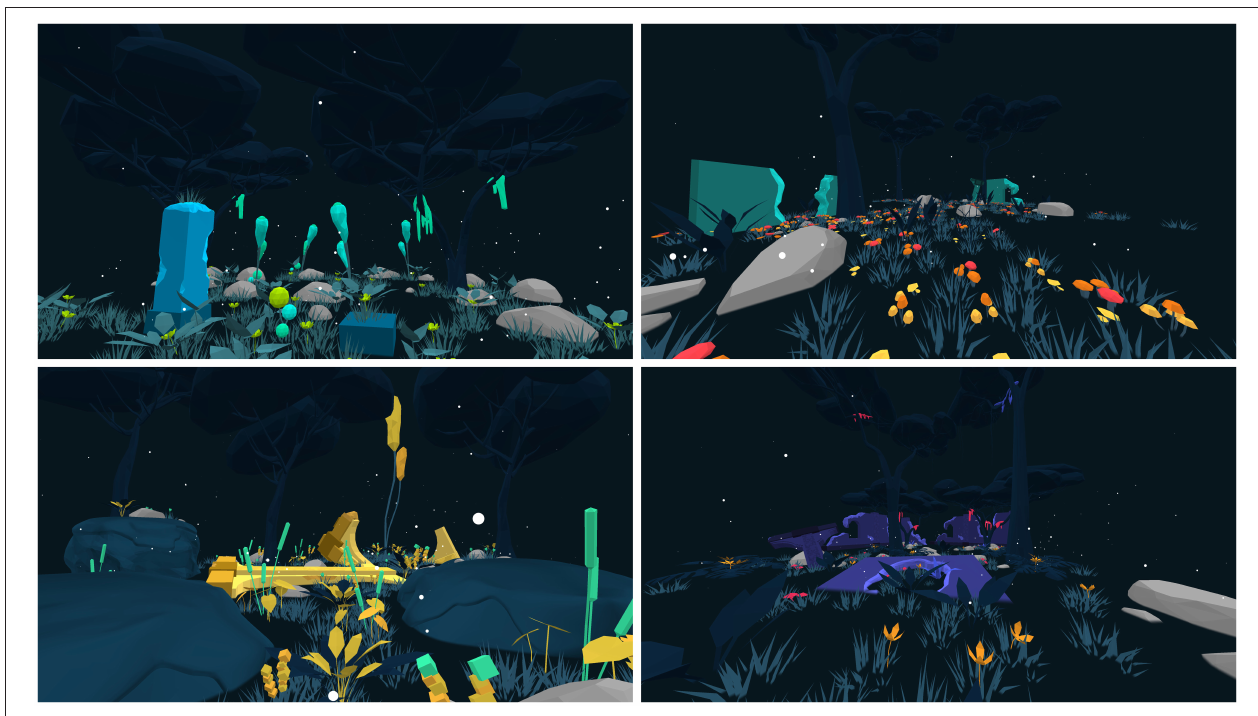
FIGURE 1 | Screenshots of some of the stylized nature environments.